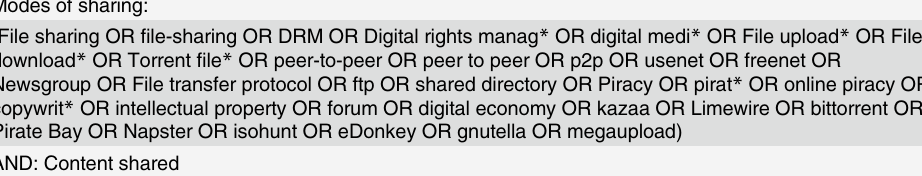
Table 1. Search strategy for academic databases. Modes of